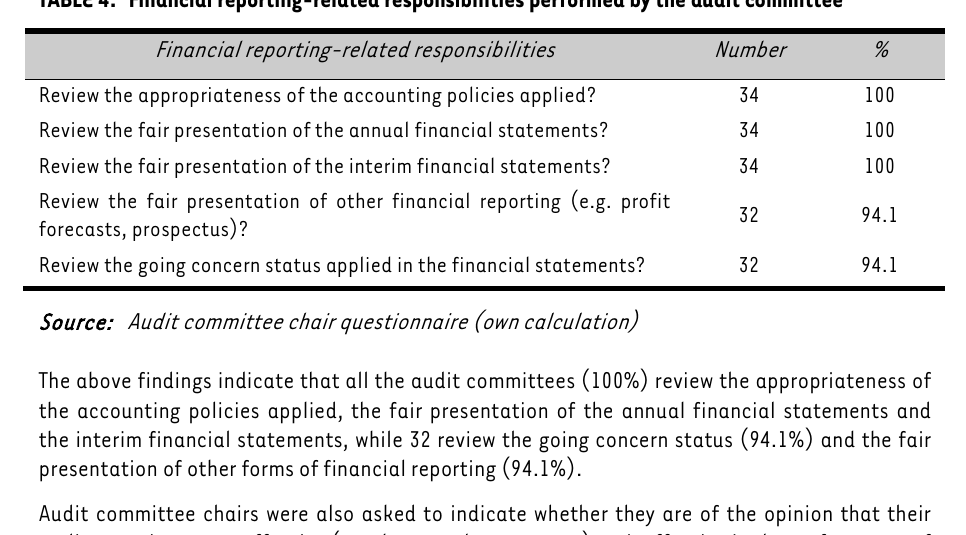
TABLE 4: Financial reporting-related responsibilities performed by the audit committee